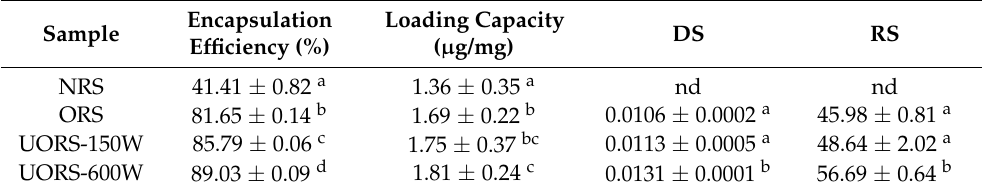
Table 1. Encapsulation efficiency/loading capacity of curcumin in emulsions stabilized by native rice starch and OSA rice